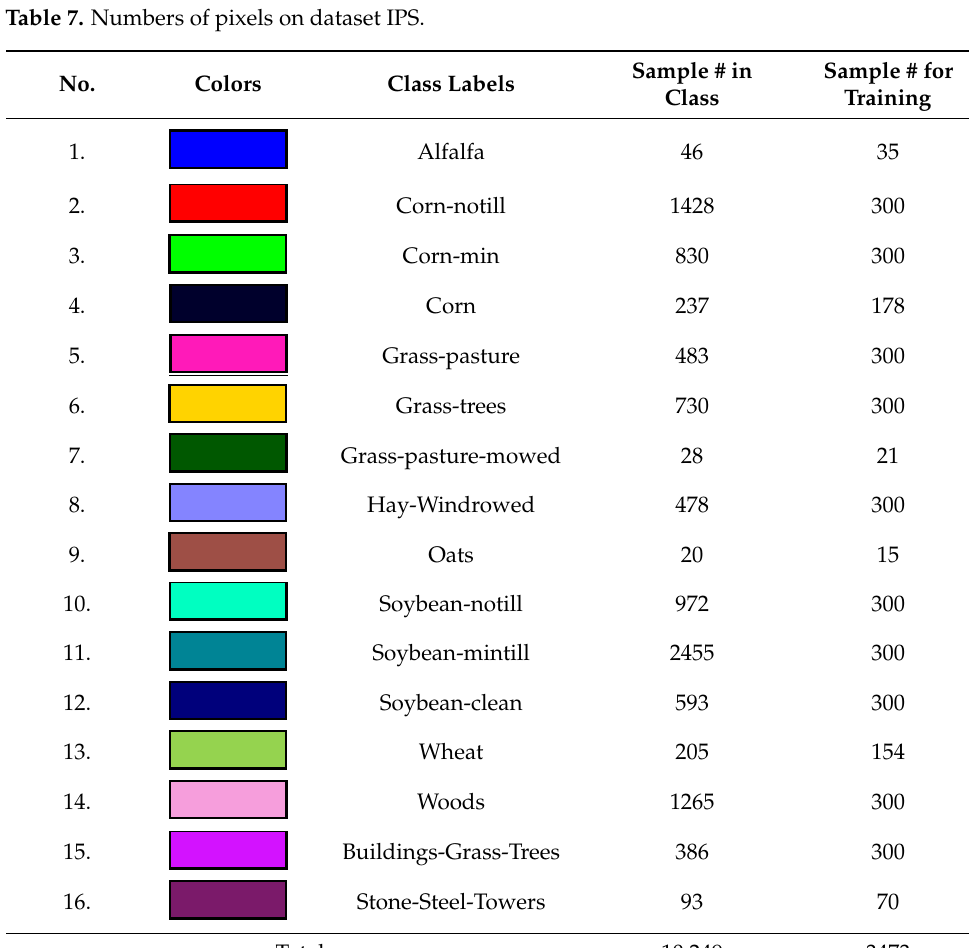
Table 4. The classification results of various DR methods on dataset Salina.